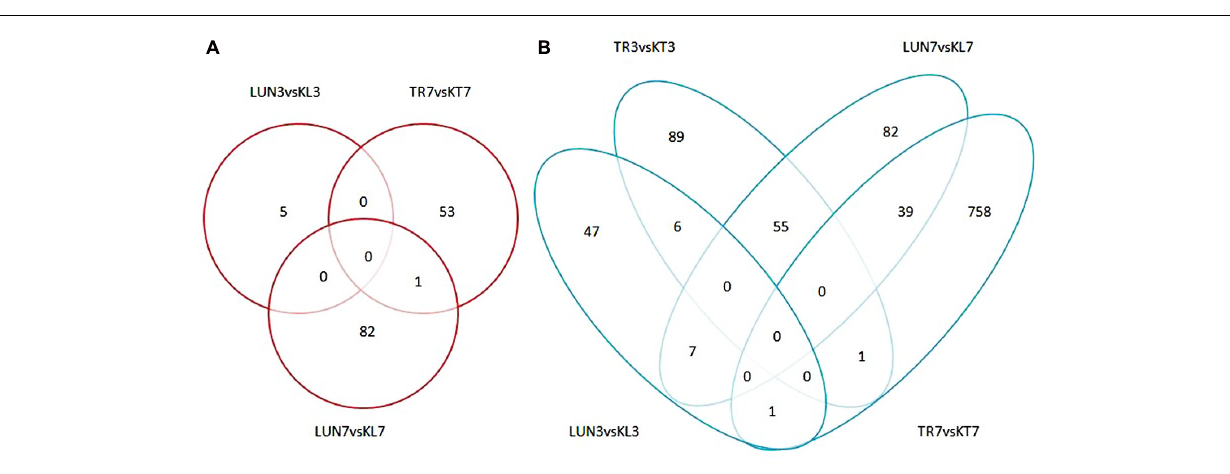
FIGURE 5 | (A) Numbers of up-regulated DEGs in infected groups and non-infected groups. (B) Numbers of down-regulated DEGs in infected groups and non-infected groups. An FDR of 0.05 was used to classify genes as DE. The lung and tracheal tissues from beagles in the control group, named KL3 and KT3 on the third day and KL7 and KT7 on the seventh day, and the experimental group named LUN3 and TRA3 on the third day and LUN7 and TRA7 on the seventh